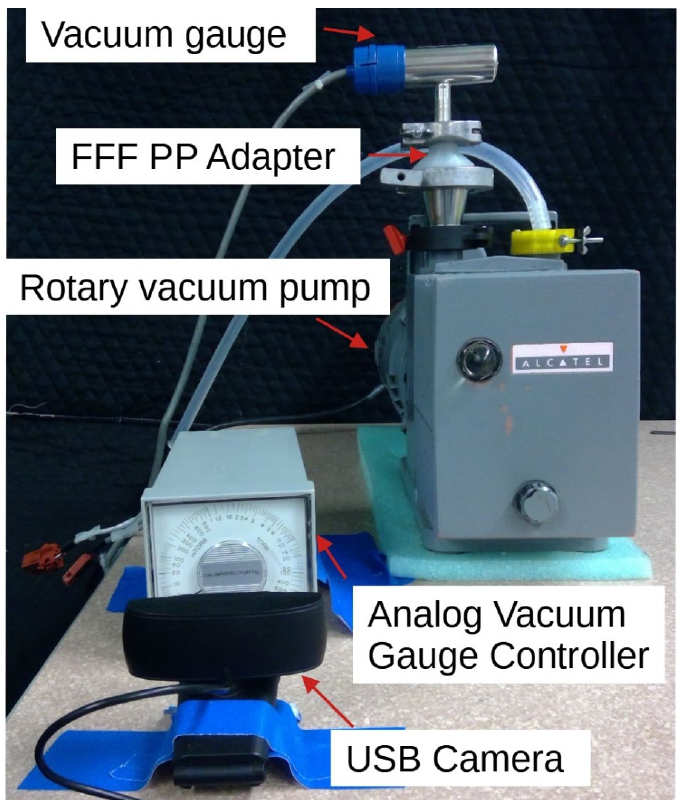
Figure 4. Experimental setup showing pump, FFF part, vacuum gauge, gauge controller and USB camera.